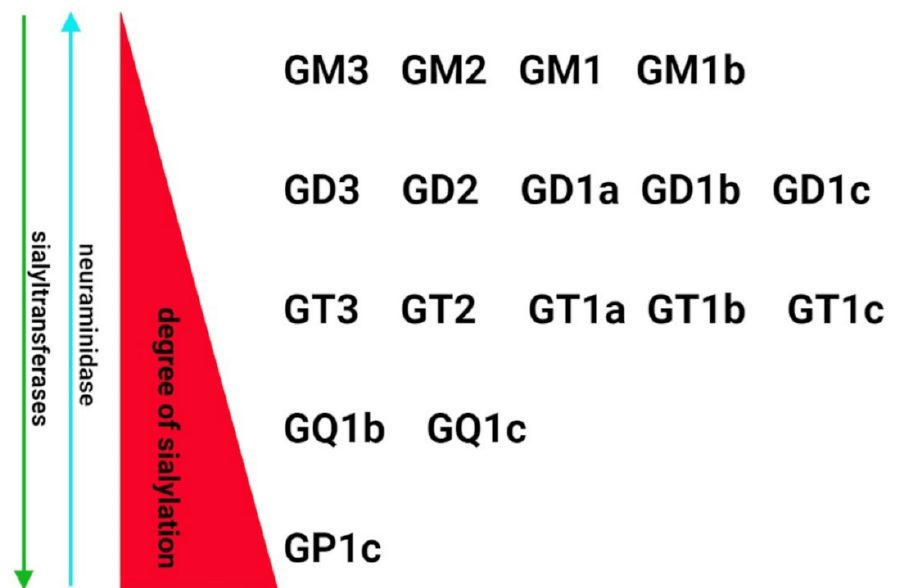
Figure 2. Sialylation pattern of representative human gangliosides. The degree of sialylation is con- trolled sialyltransferases and neuraminidase that mediate synthesis and degradation of gangliosides, respectively. The structure of the sialylated oligosaccharidic chain undergoes modulation by sialic acid-metabolizing enzymes that can be altered in response to cell activation or pathological stimuli.